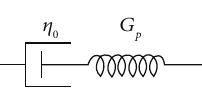
Figure 3: Maxwell model for analysis of the time-dependent response of the magnetic